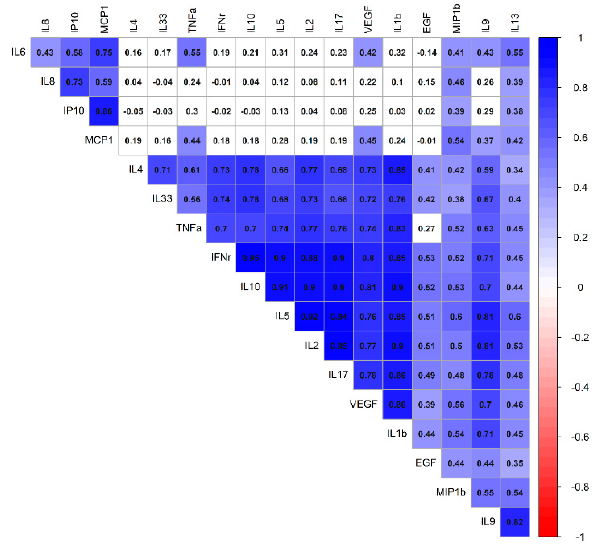
Figure 4. The correlation of various urine cytokines in Kawasaki disease before treatment. In the correlation matrix, the Spearman correlation coefficients are used (blue for positive correlations and red for negative correlations).